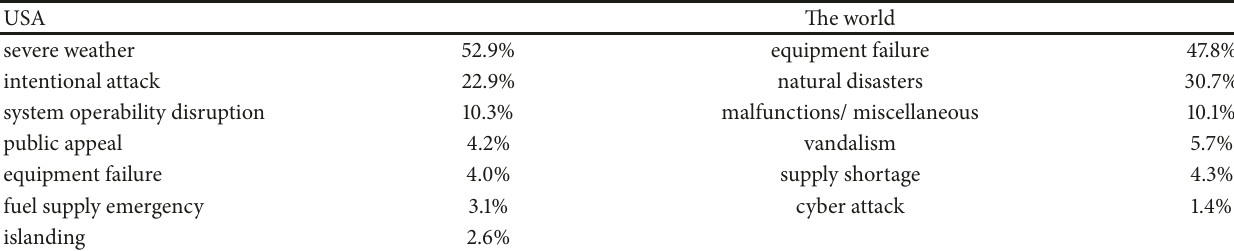
Table 2: Causes of major blackouts in the USA and the